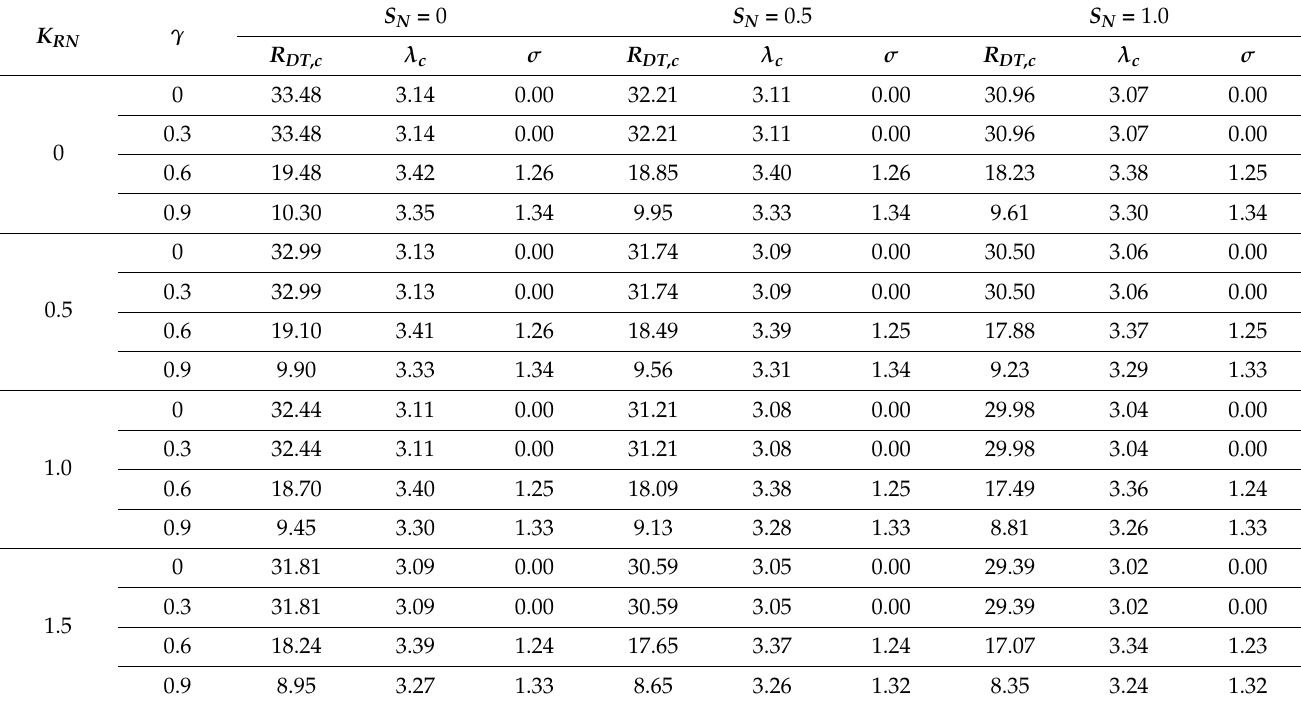
Table 1. Comparison of R DT , c , λ c , and σ for different values of γ , K RN , and S N at Le = 2, m = 1.5,